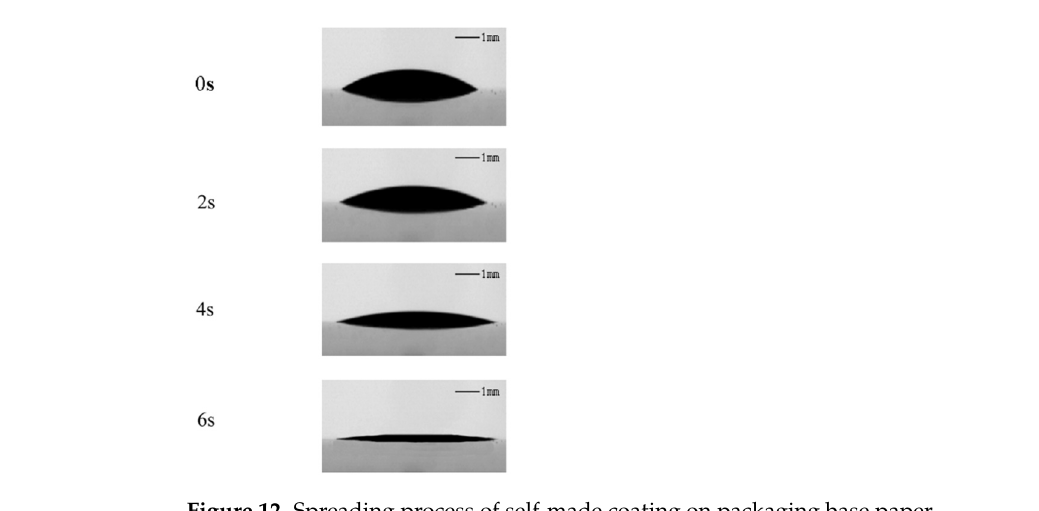
Figure 12. Spreading process of self-made coating on packaging base paper.